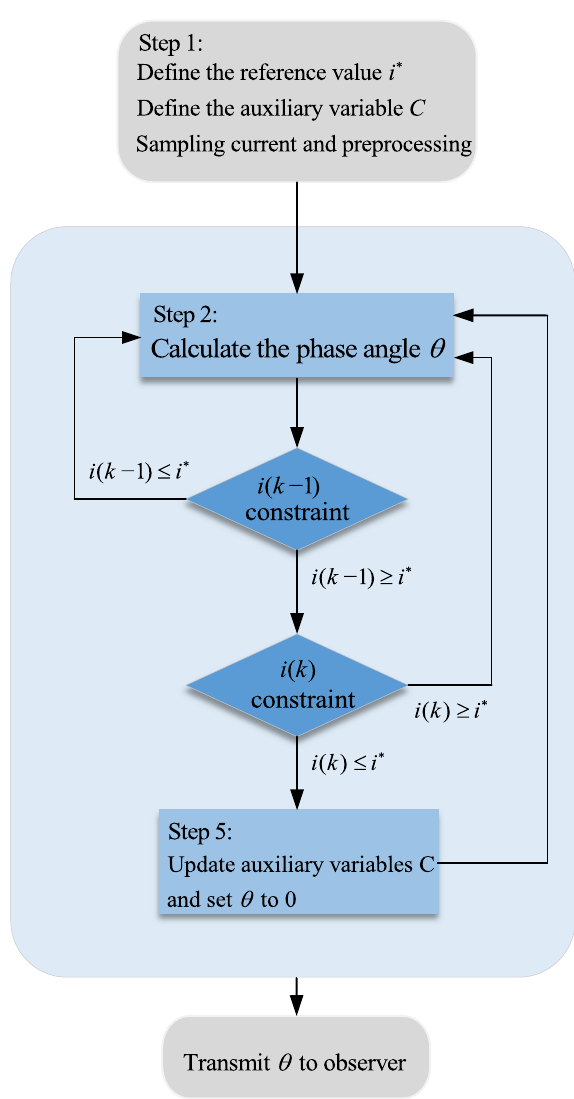
Figure 3. Steps of zero-crossing detection